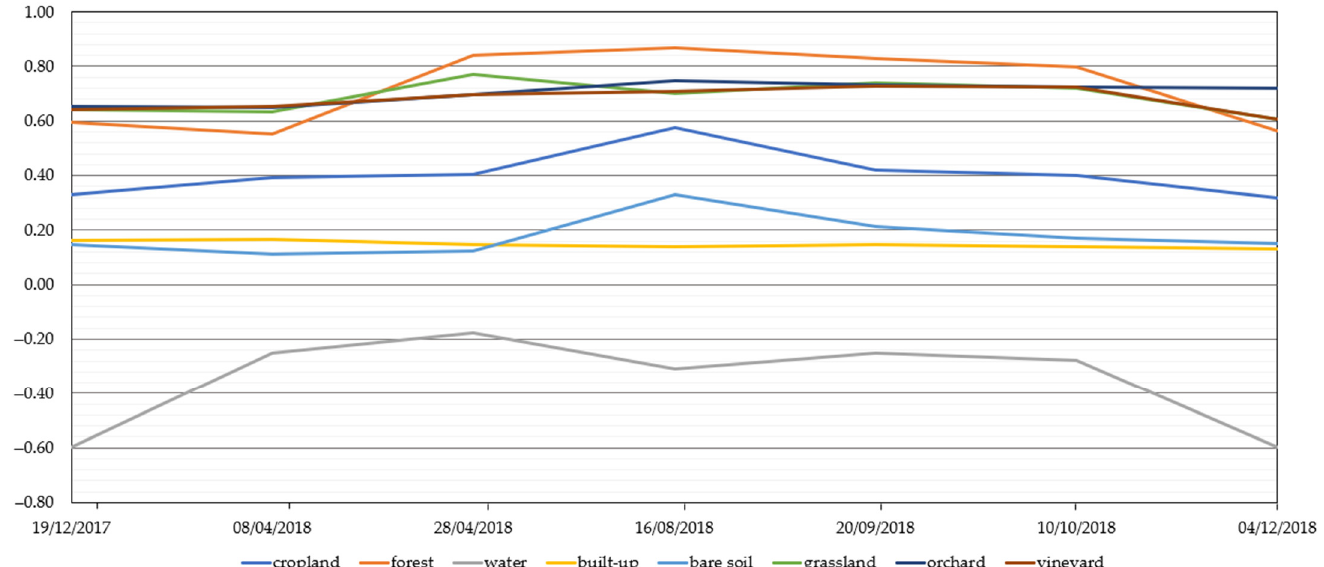
Figure 2. Temporal behavior of optical NDVI time-series profiles for LC class analysis.